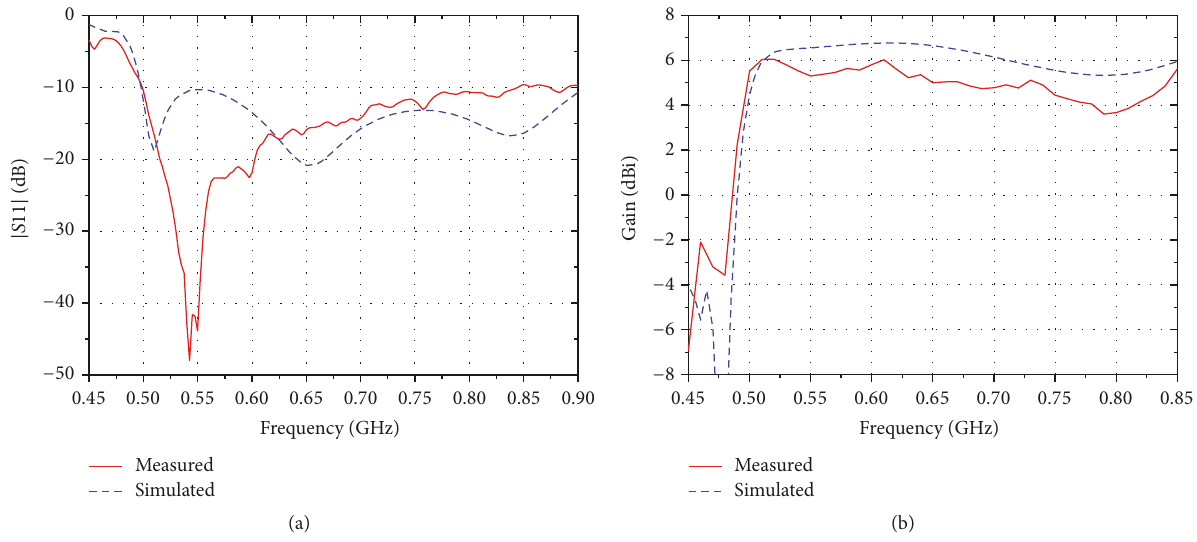
Figure 13: The simulated and measured results of the antenna in Figure 9(b): (a) return loss and (b) antenna gain.